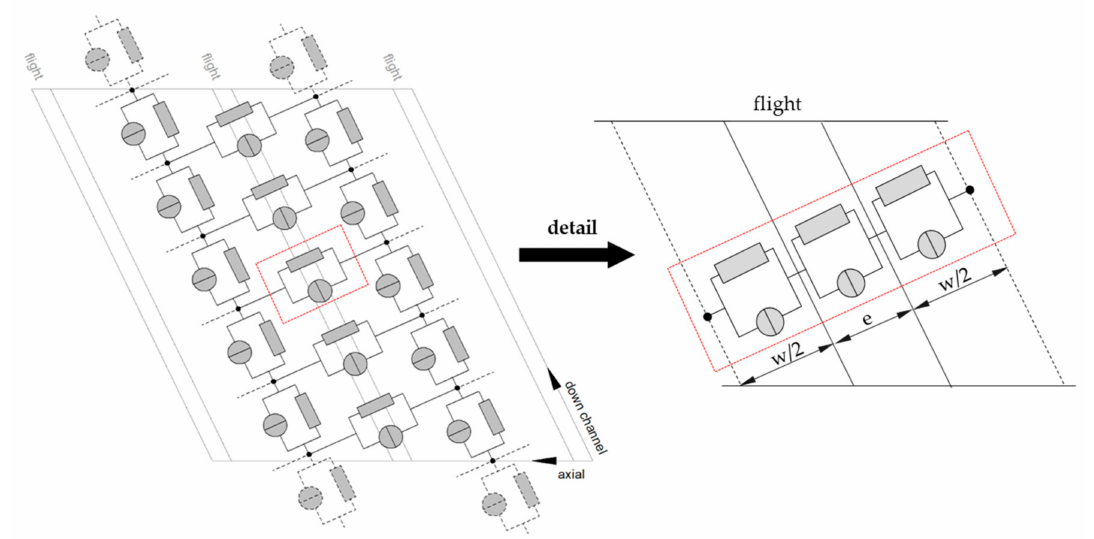
Figure 1. The development of leakage-flow models to predict flow rate and dissipation in the leakage gap of a discretized screw channel.